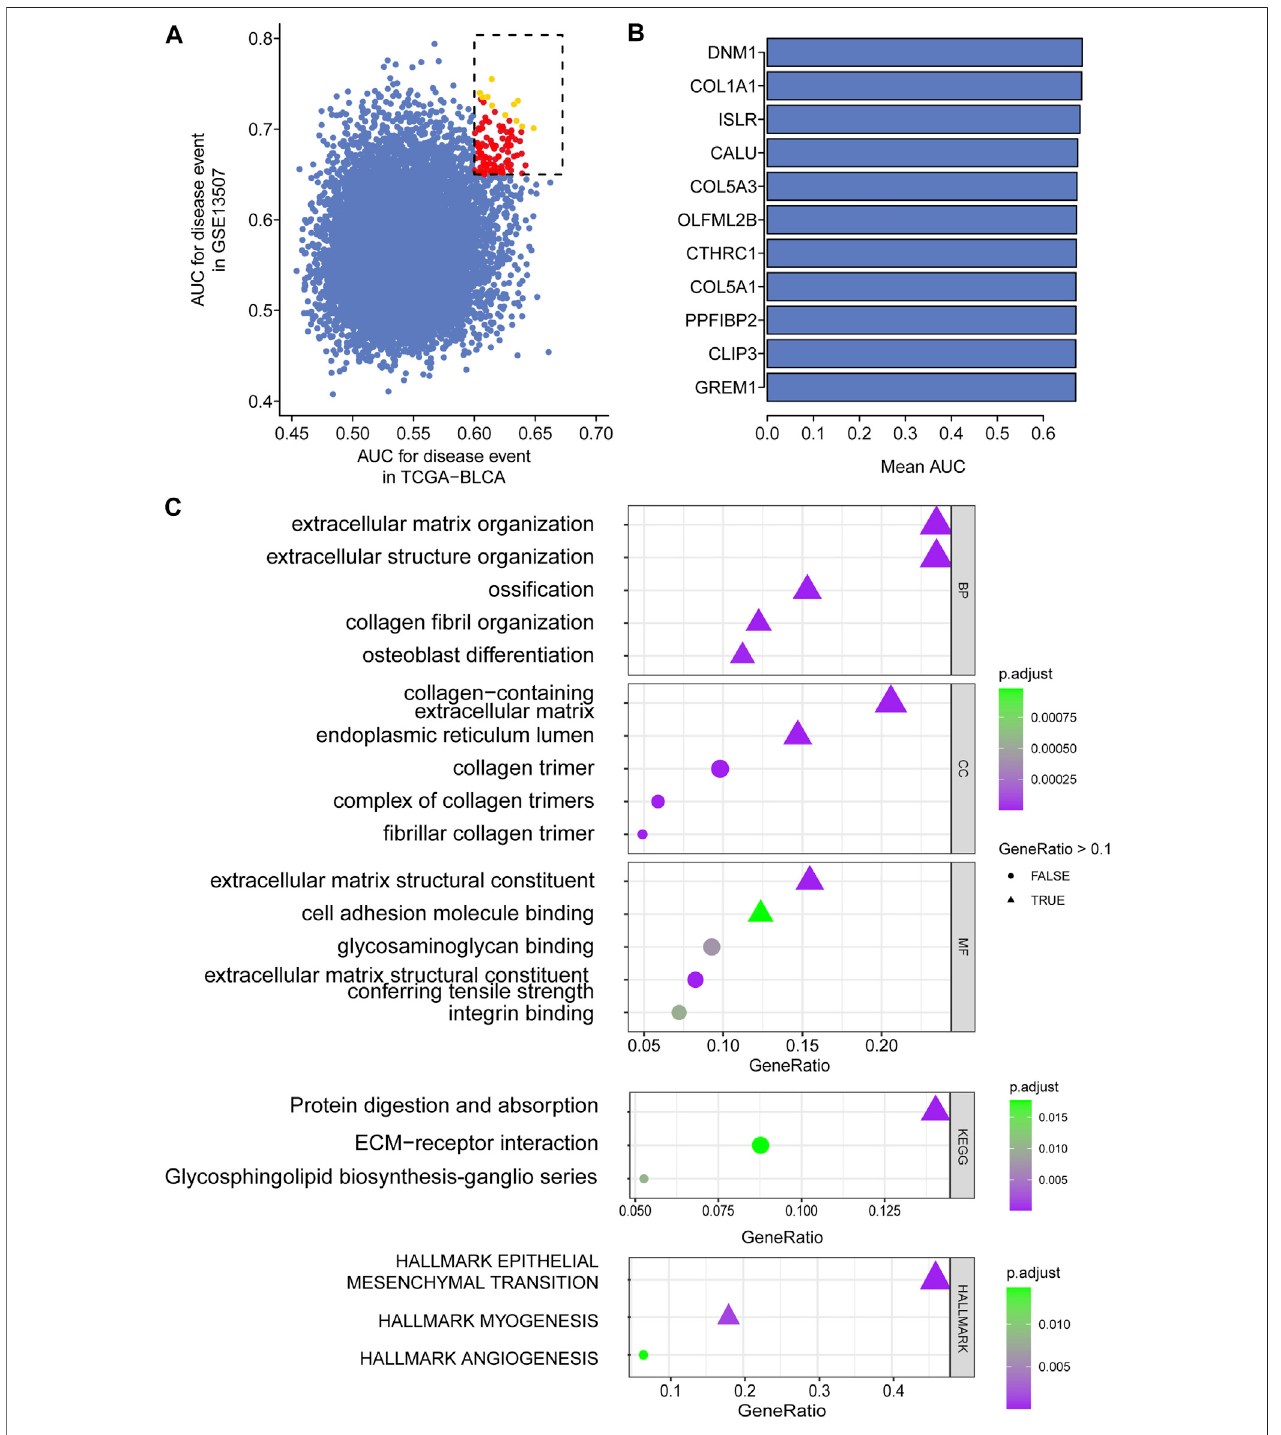
FIGURE2| TopprognosticgeneselectioninbothTCGA-BLCAandGSE13507cohorts. (A) AUCevaluationoftheprognosticvalueofcandidategenesinvolvedin overall survival based on datasets TCGA and GSE10816. (B) The average AUC value of the top 11 candidate genes. (C) Annotation of enriched signaling pathways by GO, KEGG, and HALLMARK.